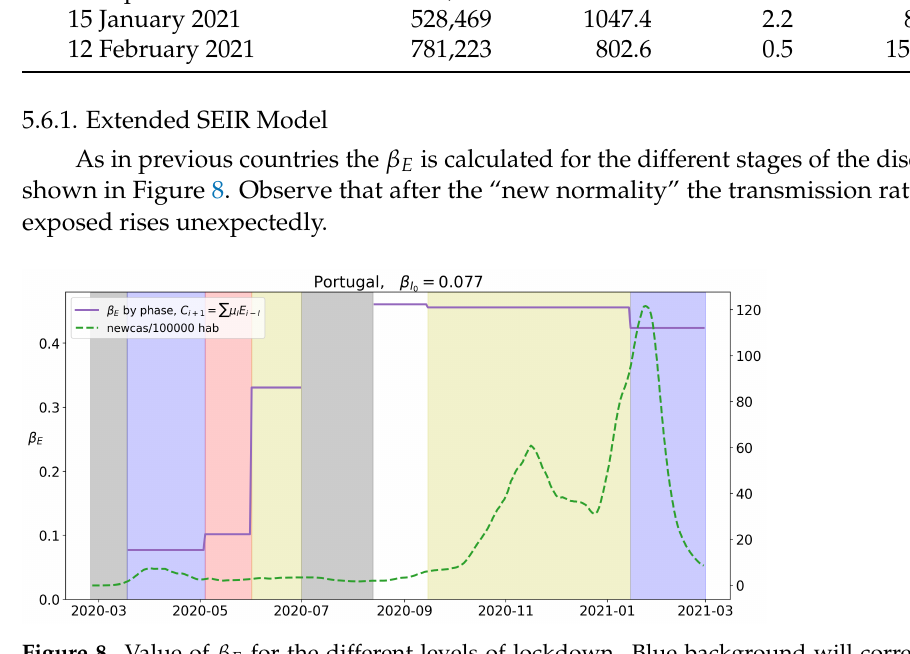
Figure 8. Value of β E for the different levels of lockdown. Blue background will correspond to Stage 1, red to Stage 2, yellow to Stage 3 and white to Stage 4. A green dotted line corresponds to the value of new cases per 100,000 hab.